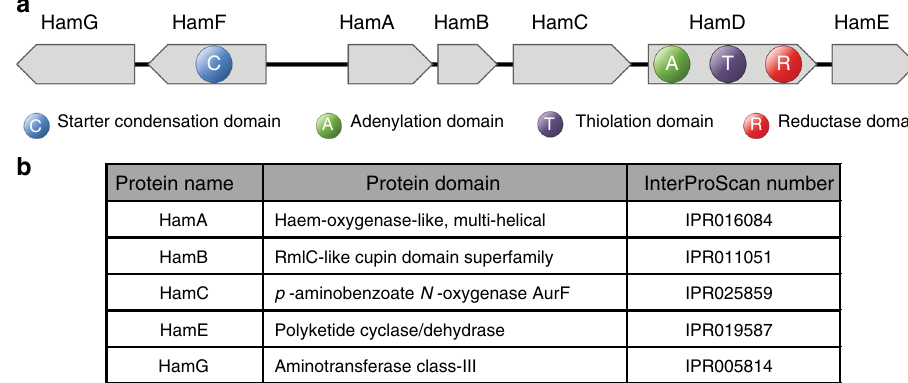
Fig. 1 Genetic organization and protein domain predictions of the ham genes. a The ham cluster is organized into two divergently orientated operons. hamD encodes an adenylation domain, a thiolation domain and a reductase domain. hamF encodes a starter condensation domain. b Predictions of protein domains and their corresponding InterProScan numbers are shown for the fi ve putative tailoring enzymes of the ham